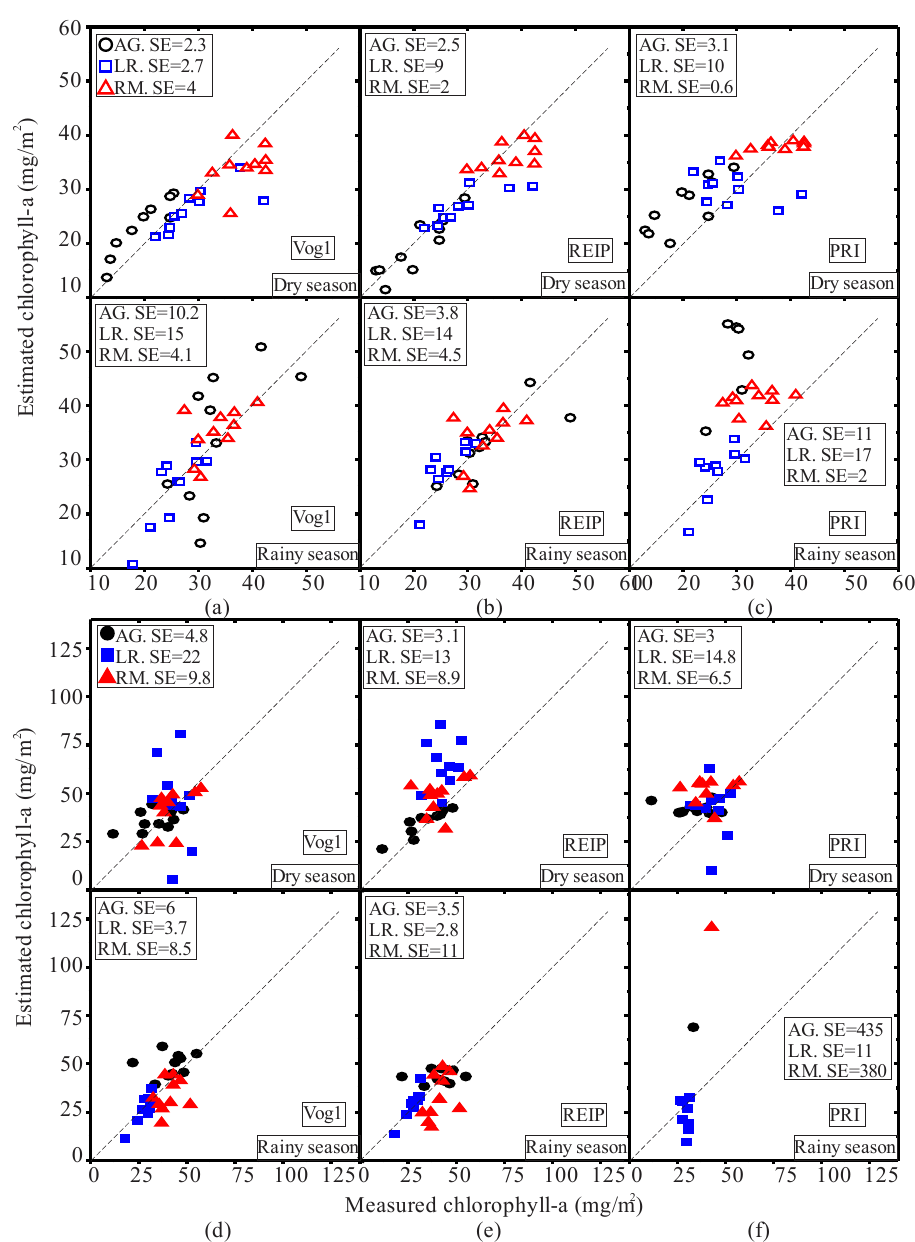
Figure 7. Predicted versus measured chlorophyll-a content during the dry and rainy seasons based on select regression equations from Tables 3 and 4. Hollow symbols indicate stressed mangroves while filled symbols indicate healthy mangroves. The standard error of estimate (SE) is indicated for each prediction. The dashed lines represent a 1:1 relation. ( a ) Stressed condition Vog1; ( b ) REIP; and ( c ) PRI; ( d ) healthy condition Vog1; ( e ) REIP; and ( f ) PRI.